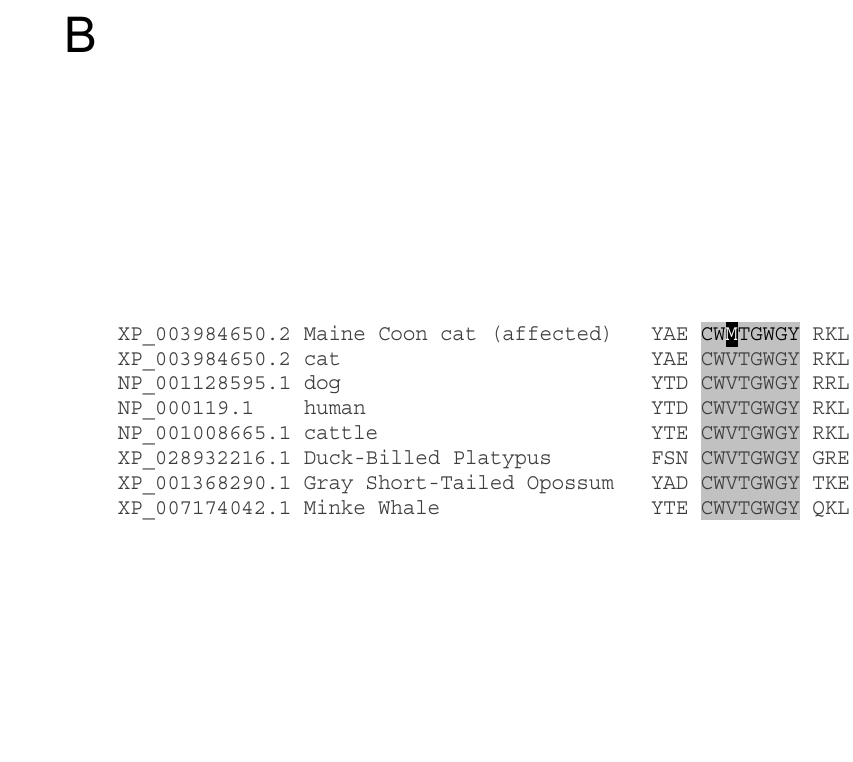
Figure 1. The FXI V516M substitution. ( A ) DNA and predicted amino acid sequence for a portion of exon 13 of the F11 mRNA surrounding the single base substitution (XM_003984601.5:c.1546G>A) in Maine Coon cats. The top sequence is from a homozygote for wild-type fFXI-V516 (XP_003984650.2), the middle sequence from a homozygote for the missense variant fFXI-M516, and the bottom sequence from a heterozygote for fFXI-V516 and fFXI-M516. The top lines show the DNA codons in grey boxes, with the predicted amino acid sequences below. ( B ) Predicted FXI amino acid sequence alignments (Clustal Omega [28]) of the part of the FXI catalytic domain containing the V516M substitution. Shown are sequences from a MCC homozygous for the missense variant FXI-M516 (top) and several other mammals. Conserved amino acids are shaded in grey, and the missense variant in the FXI-deficient MCC is shaded black. Numbers on the right mark the last amino acid per row. NCBI database accession numbers are: XP_003984650.2 (feline), NP_001128595.1 (canine),